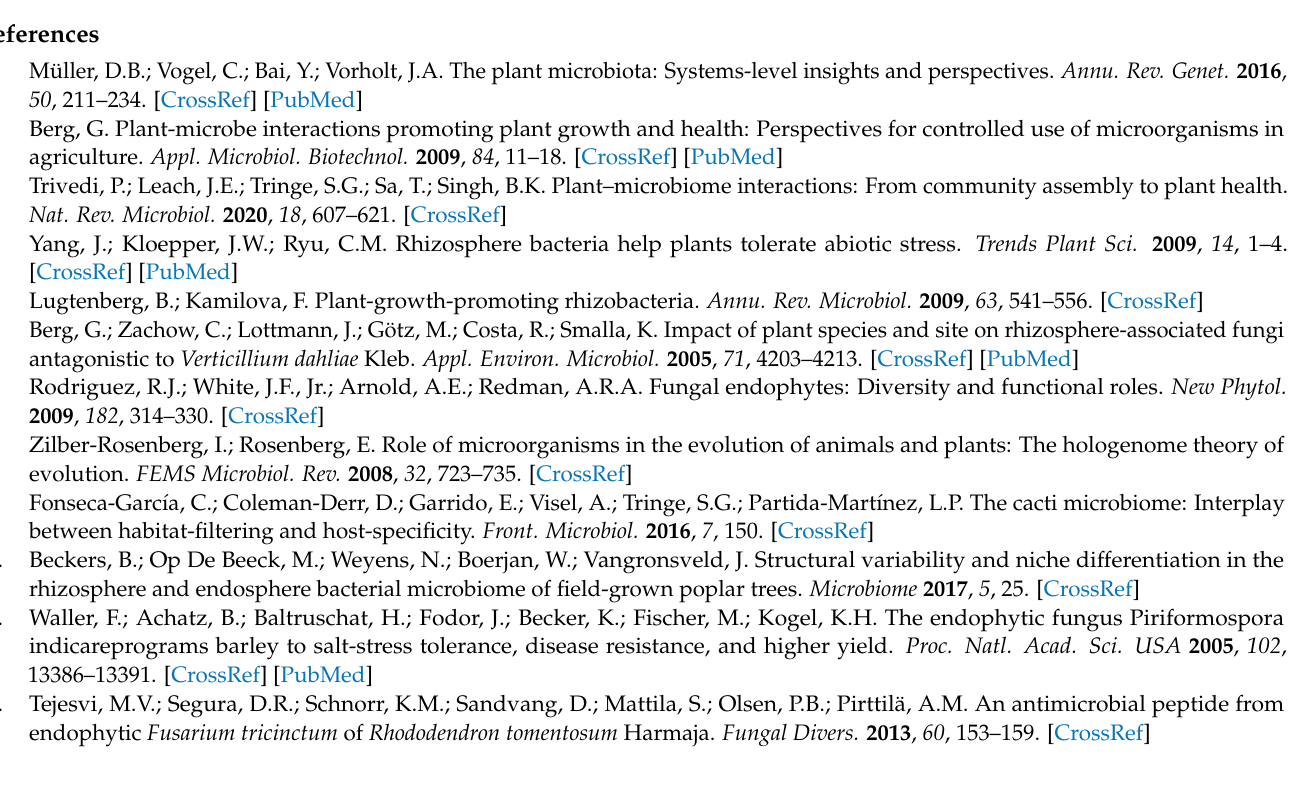
Supplementary Materials: The following are available online at https://www.mdpi.com/article/10 .3390/jof8111210/s1, Table S1: Mean relative abundances of top 10 differential phyla (%) in different sample types, Table S2: Growth index table of C. camphora in different plots, Table S3: Soil physical and chemical properties of different plots, Table S4: Soil enzyme activities of different plots, Table S5: The microclimate in the C. camphora forest of different plots. Figure S1: The X-axis represents species (the top 10 species with the lowest p values are shown); Y-axis represents the relative richness of species; columns with different colors represent samples; and * on the columns indicates that the difference is significant ( p < 0.05). ** means the difference is very significant ( p < 0.01), Figure S2: Soil enzyme activities, including soil acid phosphatase (S-ACP), soil catalase (S-CAT), soil sucrase (S-SC) and soil urease (S-UE), in the uphill and downhill sample plots of C. camphora were studied. Different letters indicated the significance at p < 0.05, Figure S3: The microclimate in the forest of C. camphora uphill and downhill sample plot, Figure S4: Redundancy analysis (RDA) ordination plots demonstrate the relationship between soil enzyme activities and forest microclimate and fungal communities at the (a) phylum and (b) class